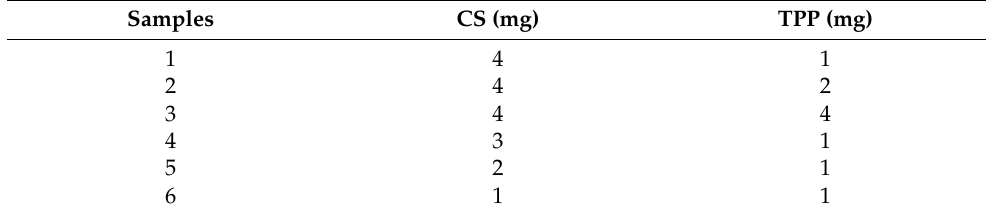
Table 1. Composition of CS/TPP